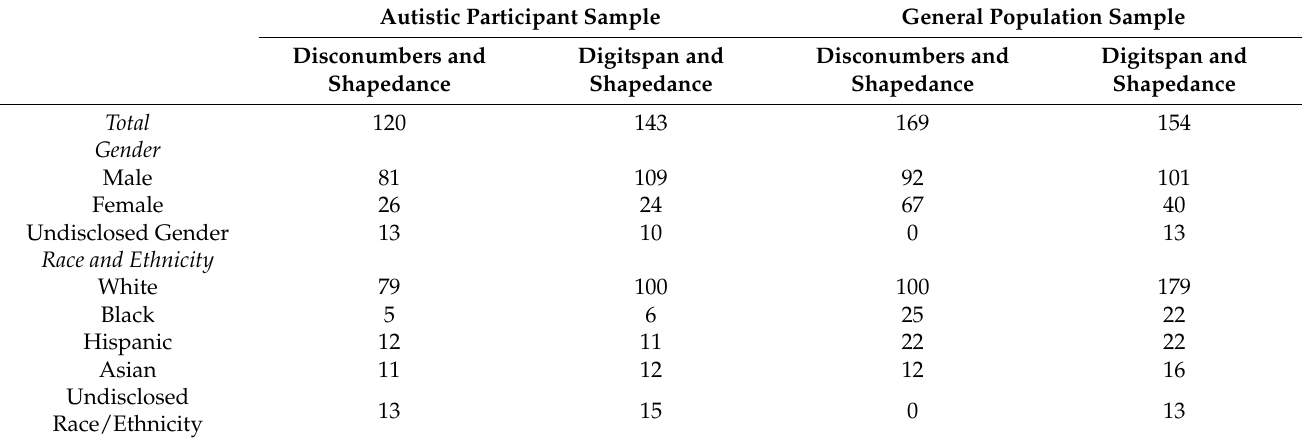
Table 1. Detailed Demographic Breakdown of Participants and Cognitive Measure Packages. Autistic Participant Sample General Population Sample Disconumbers and Digitspan and Disconumbers and Digitspan and Shapedance Shapedance Shapedance